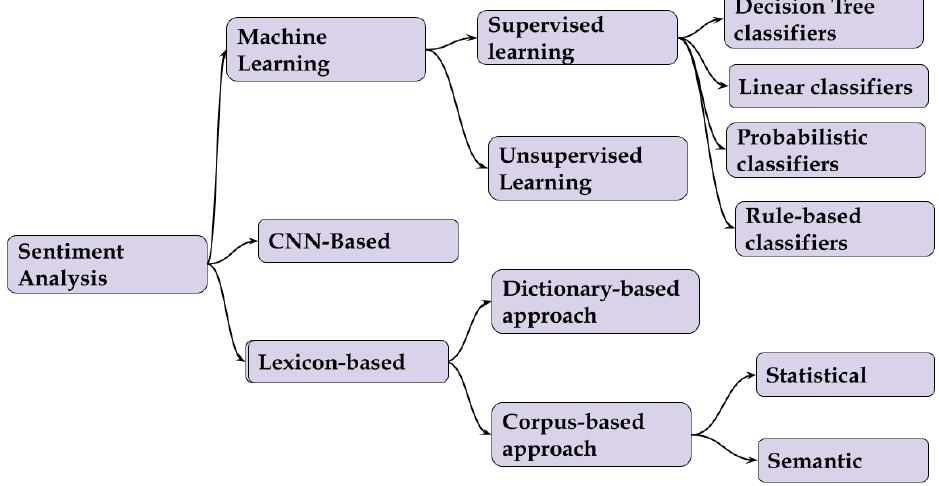
Figure 2. Sentiment analysis approaches in e-commerce recommendations. Sentiment analysis is divided into three main approaches to analyze the text, as